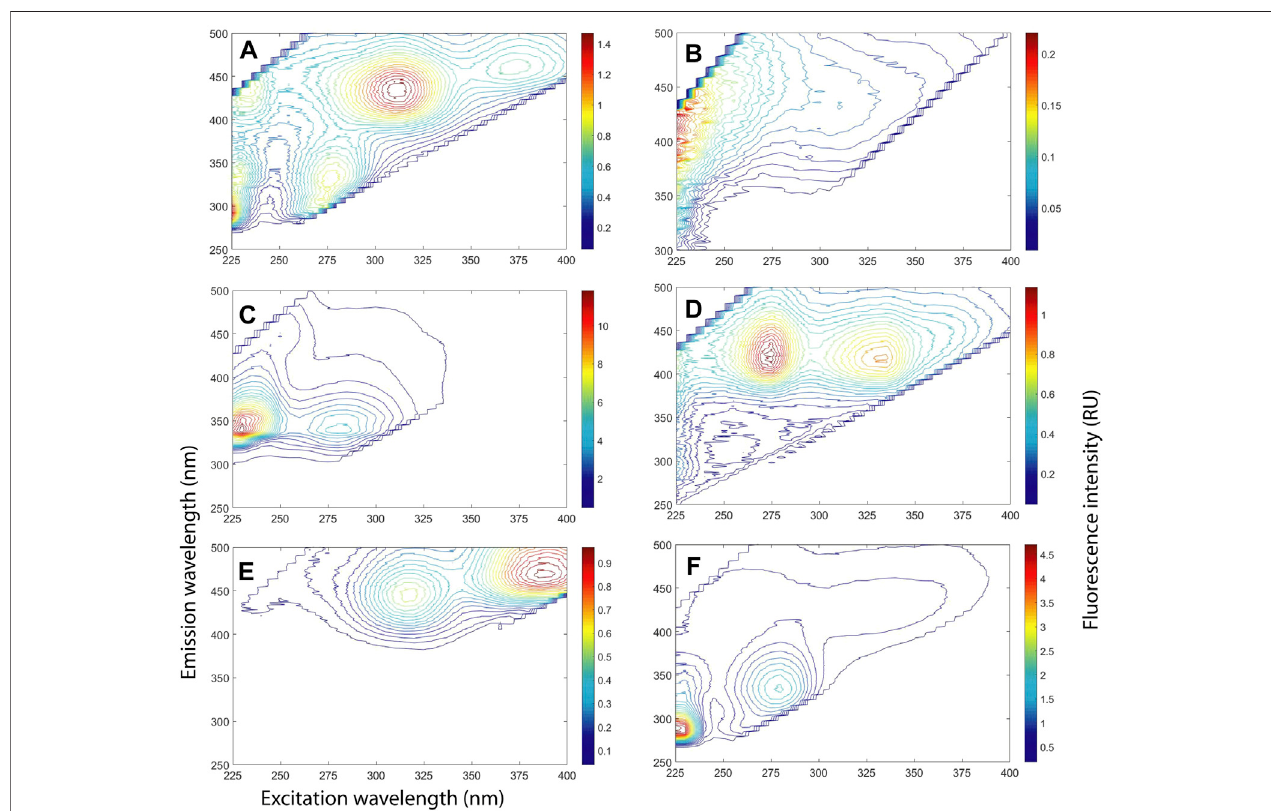
FIGURE 5 | EEM spectra of common natural and anthropogenic DOM sources during the late monsoon at the Ganges and Brahmaputra rivers basins: (A) algae, (B) groundwater, (C) industrial ef fl uents, (D) soil, (E) terrestrial plants, and (F) sewerage water. These samples were collected separately from their sources and measured using a fl uorescence spectrophotometer.